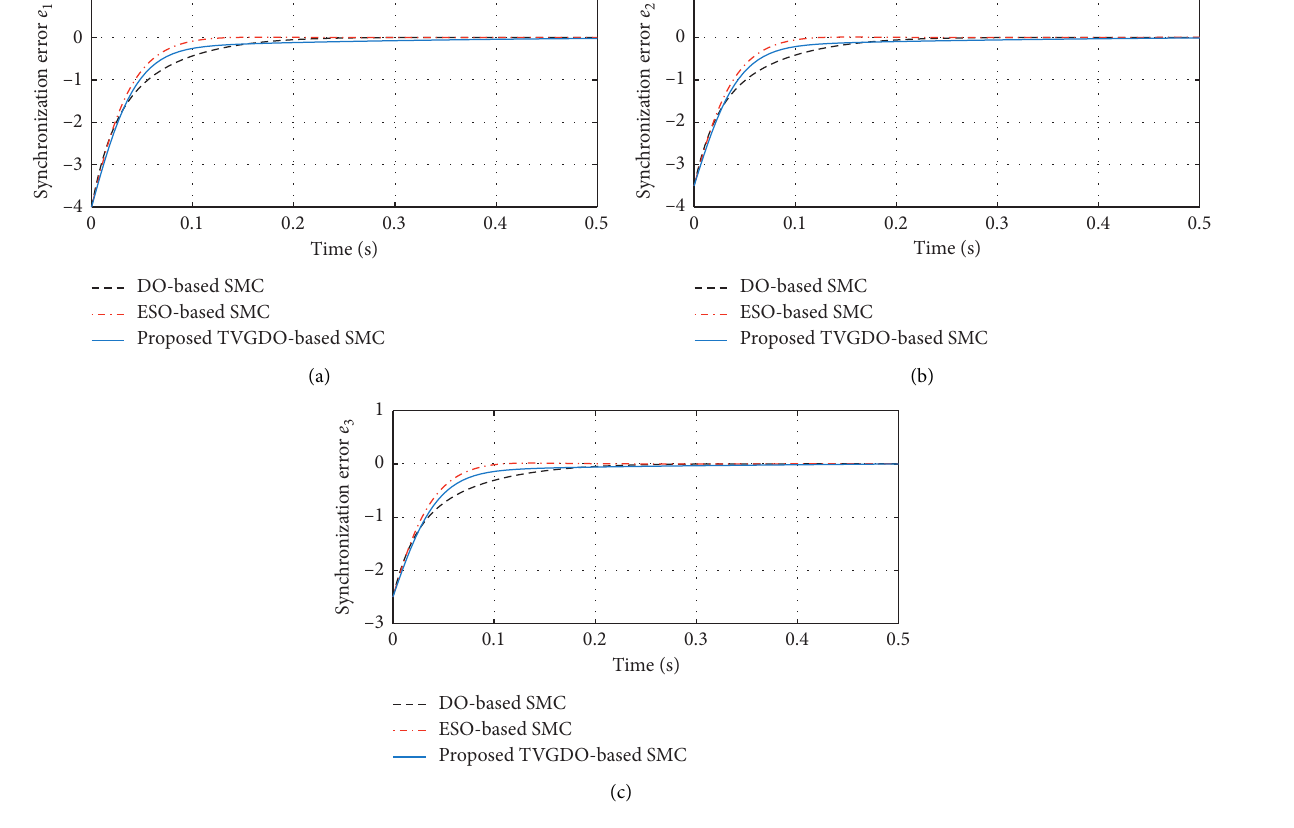
Figure 2: Synchronization error (Case